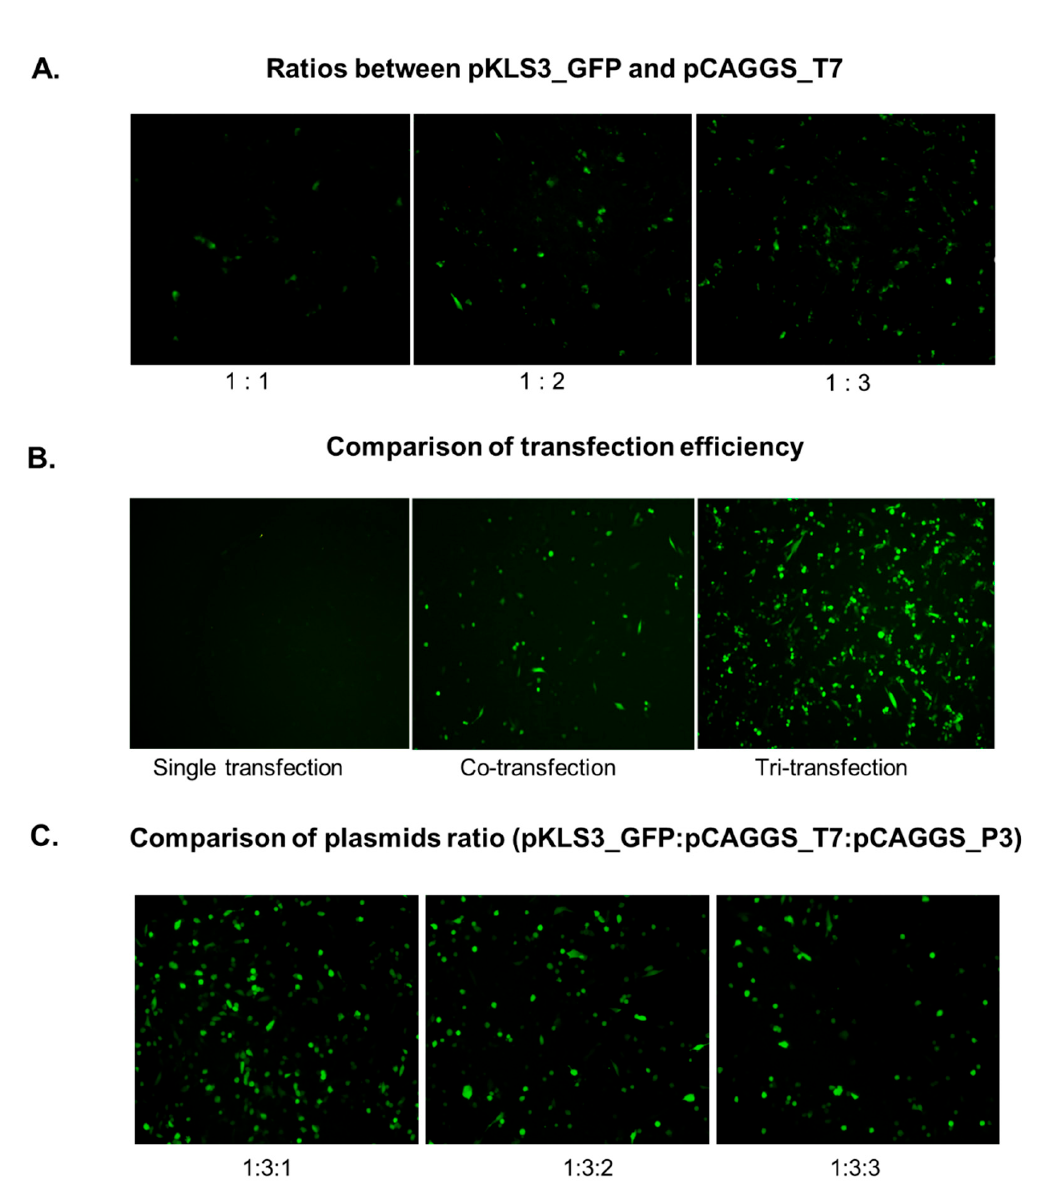
Figure 5. Photographs illustrating green fluorescent signals in transfected cells at x100 magnification. ( A ) The BHK-21 cells were co-transfected with pKLS3_GFP and pCAGGS_T7 at various ratios (pKLS3_GFP: pCAGGS_T7 = 1:1, 1:2, and 1:3). The GFP expression level was enhanced by the increased amount of the plasmid carrying T7 RNA polymerase, and the highest signal was observed when pCAGGS_T7 was three times pKLS3. ( B ) Tri-transfection with pKLS3_GFP, pCAGGS_T7, and pCAGGS_P3 dramatically elevated the GFP expression level compared to co-transfection with pKLS3_GFP and pCAGGS_T7. No detectable signal was observed in the single plasmid, pKLS3_GFP, transfected cells. ( C ) BHK-21 cells were tri-transfected with various ratios of pKLS3_GFP: pCAGGS_T7: pCAGGS_P3 (1:3:1, 1:3:2, and 1:3:3) and the optimum ratio was 1:3:1 as it produced the highest fluorescent